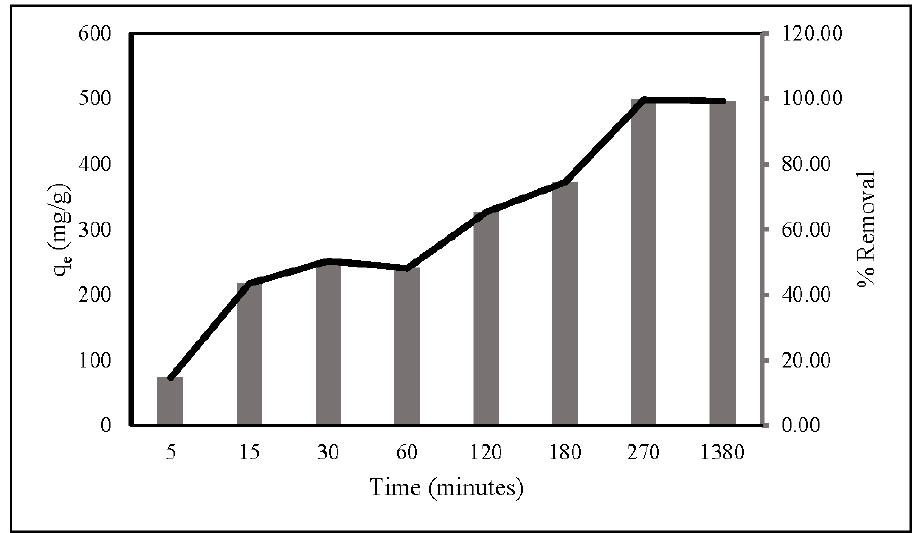
Figure 7. Contact times during nitrate adsorption. (10 mg of ZLCH-Fe; initial NO 3 : 100 mg/L; pH: 7.)